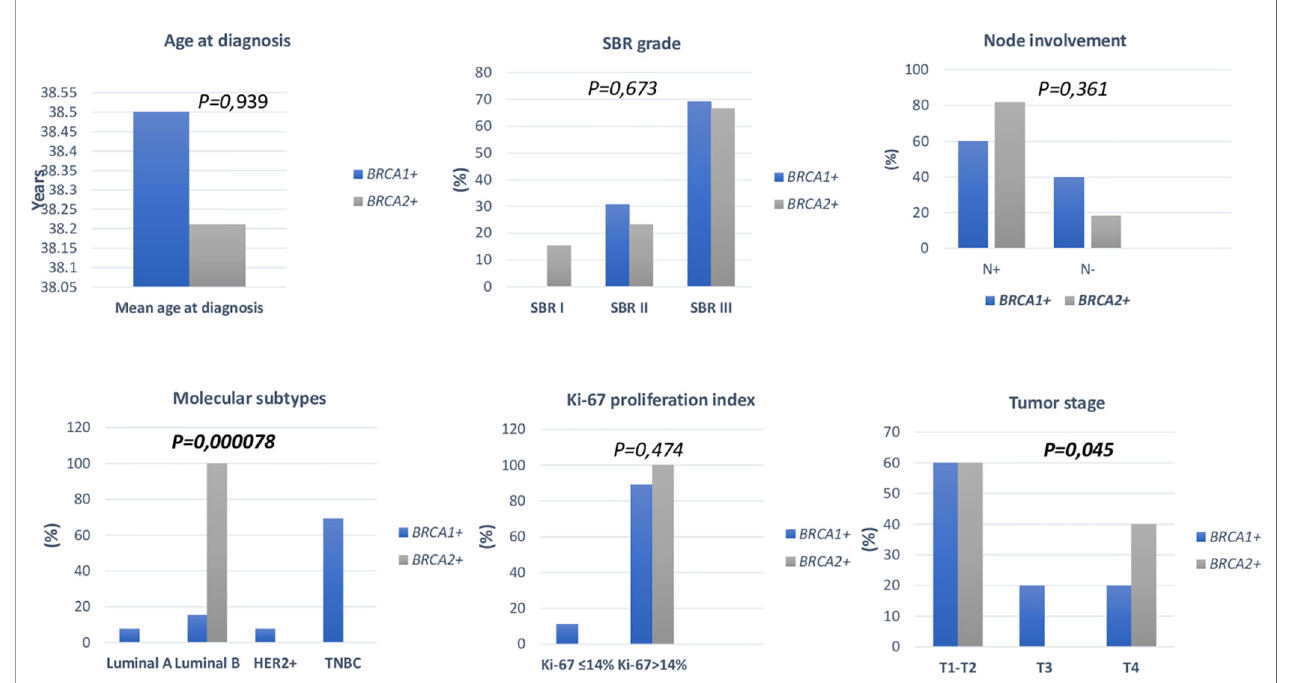
FIGURE 4 | Distribution of clinico-pathological features of breast cancer in BRCA1 + and BRCA2 + patients.